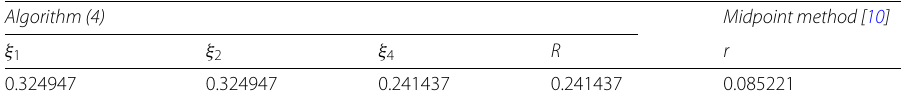
Table 1 Parameters for example